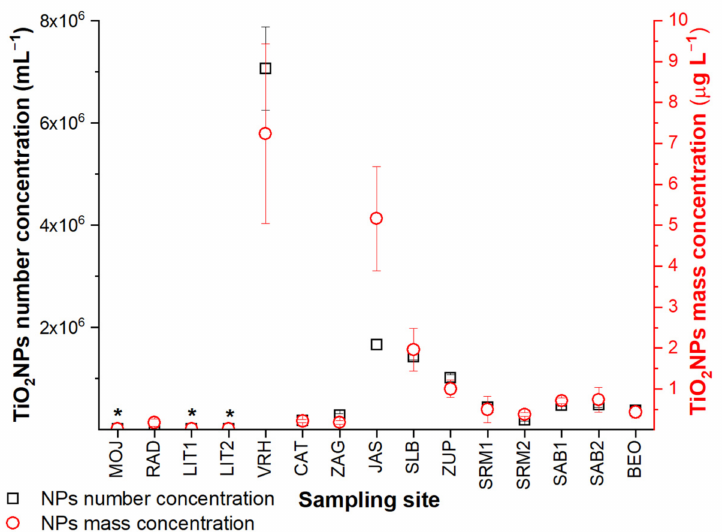
Figure 2. Mass and number concentration of TiO 2 NPs determined in water samples from 15 different locations of the Sava River. Data represent the mean ± STD of four replicates (N = 4). Asterisk (*) denotes sampling sites with TiO 2 NPs concentrations below